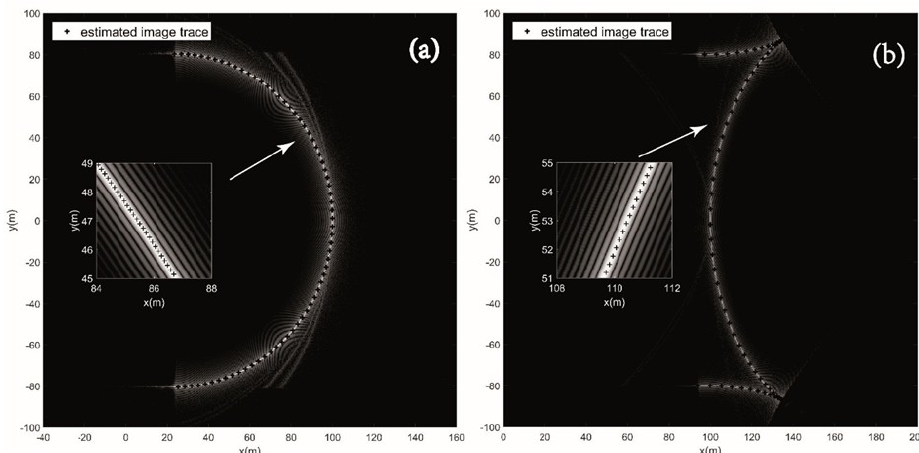
Figure 18. Estimated image trace and its SAR image. ( a , b ) represent the target moving in the clockwise and counter-clockwise direction, respectively. The estimated trace is indicated with ‘+’ symbols.